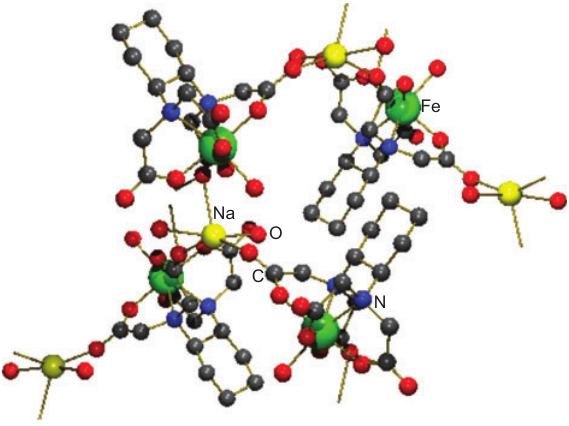
Figure 3 View of the part of Fe(H van Eldik, 1998 ).